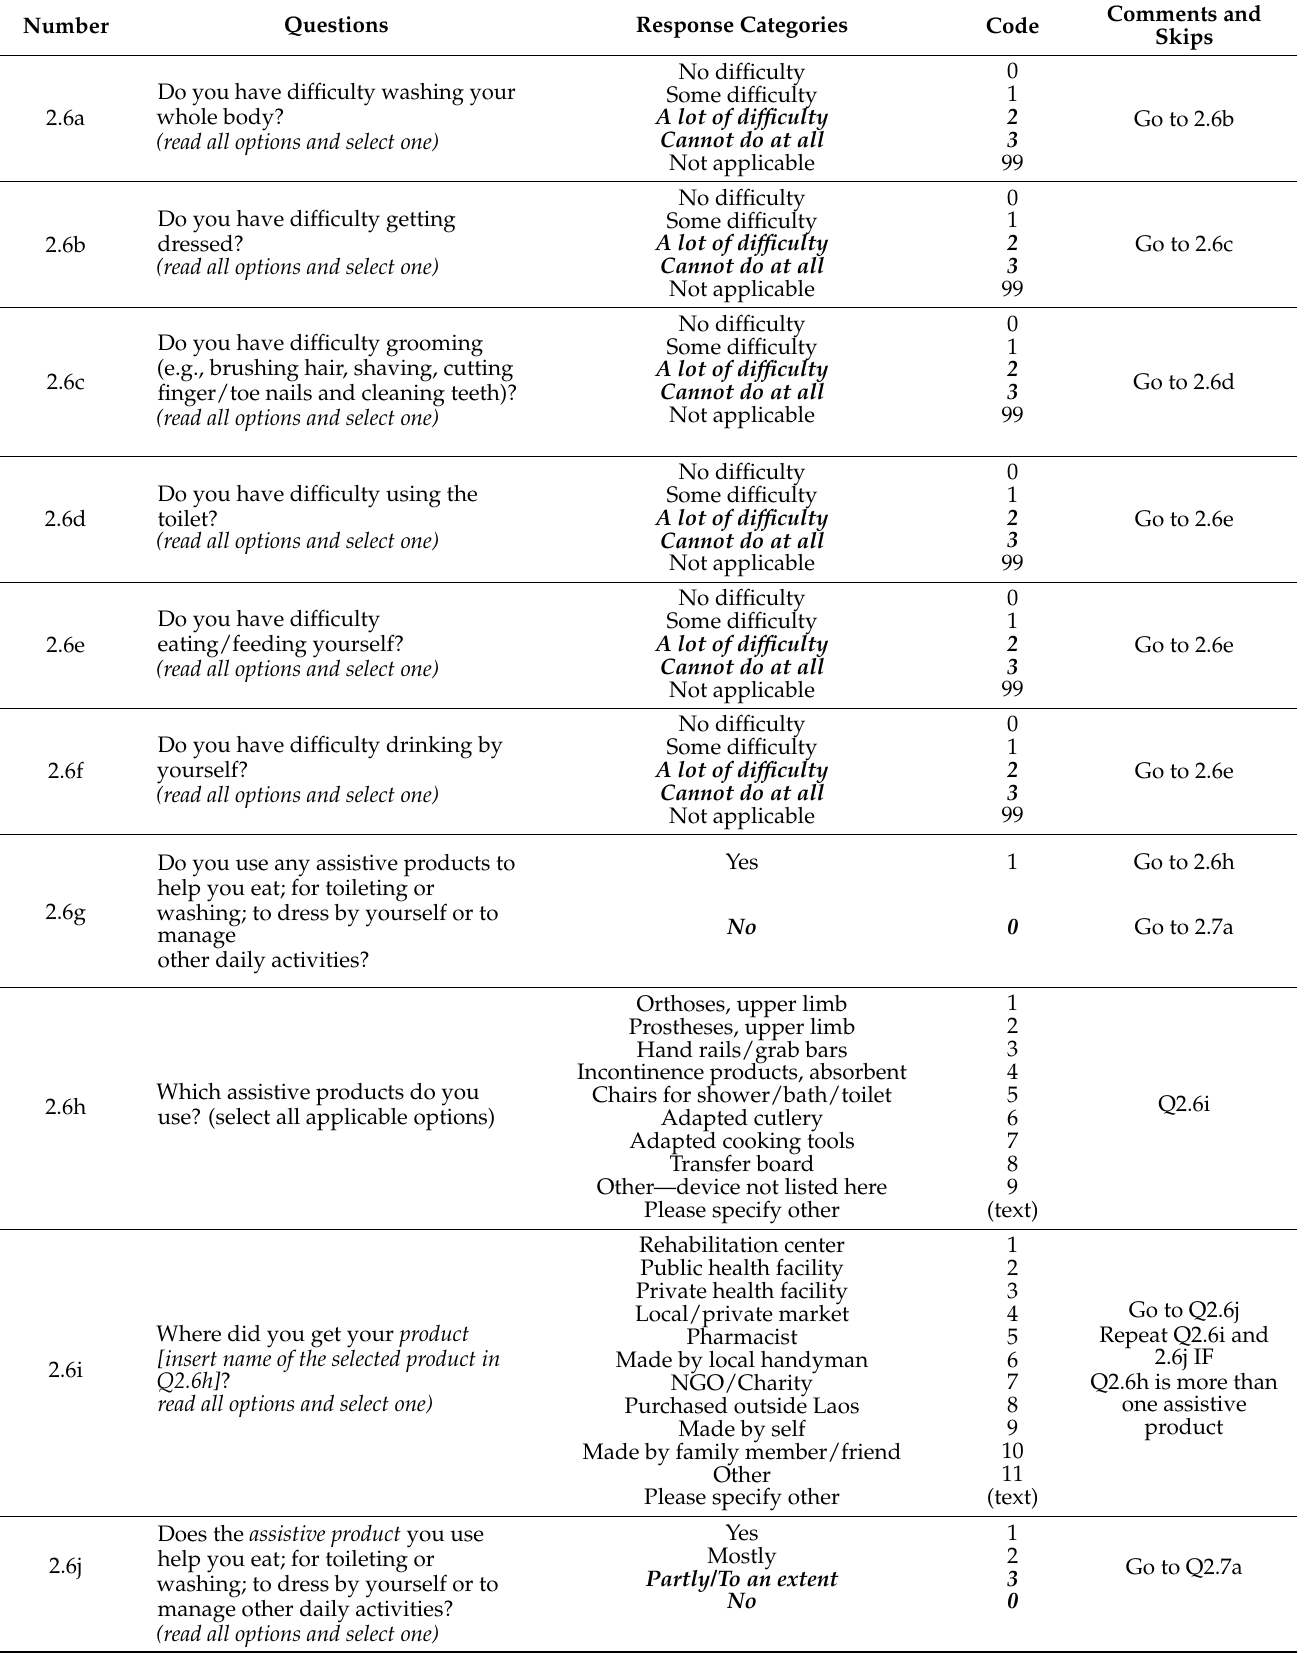
Table 1. Questions on self-care domain in Module 2, Function and Assistive